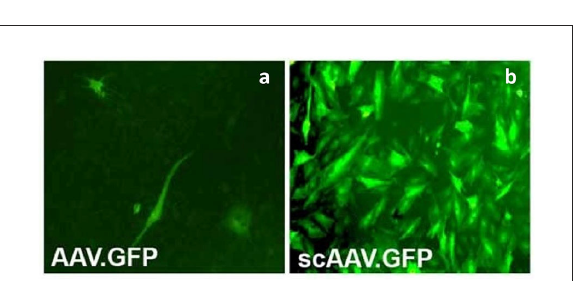
FIGURE2 Primary articular fibroblasts from rabbits transduced with the same dose of conventional AAV encoding GFP (AAVGFP) (a) or double-stranded, self-complementary AAV encoding GFP (scAAVGFP) (b) . scAAV vectors produced a ∼ 25-fold greater transduction compared to the conventional AAV vector. Reproduced with permission from Kay et al.